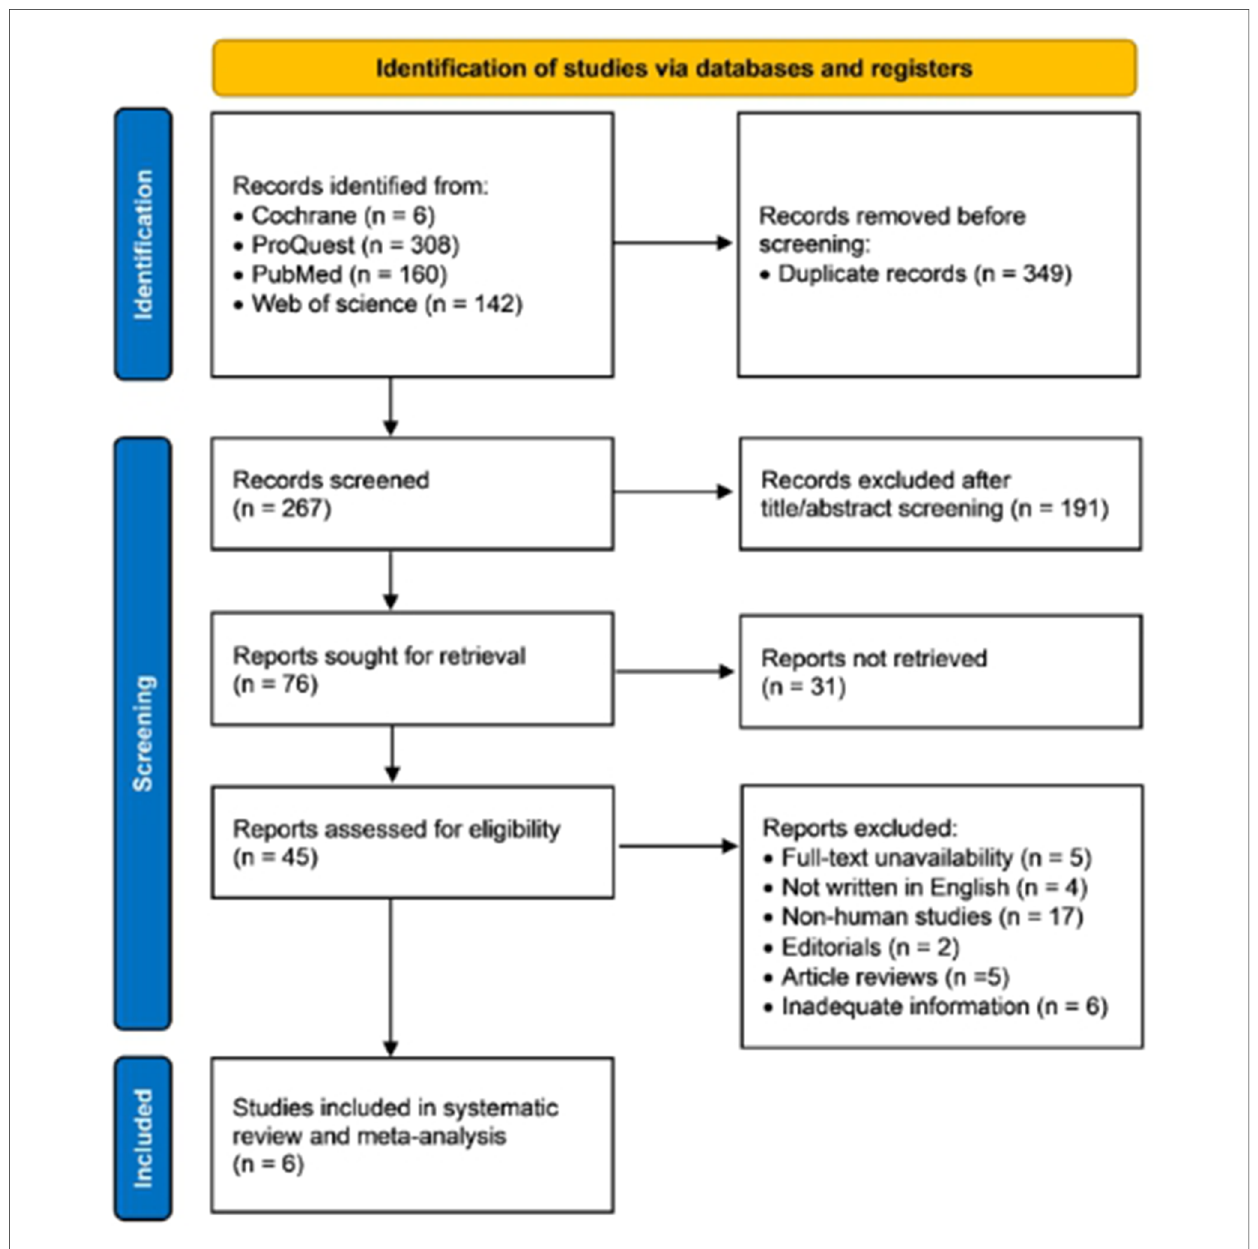
FIGURE 1 Flow diagram of the study selection